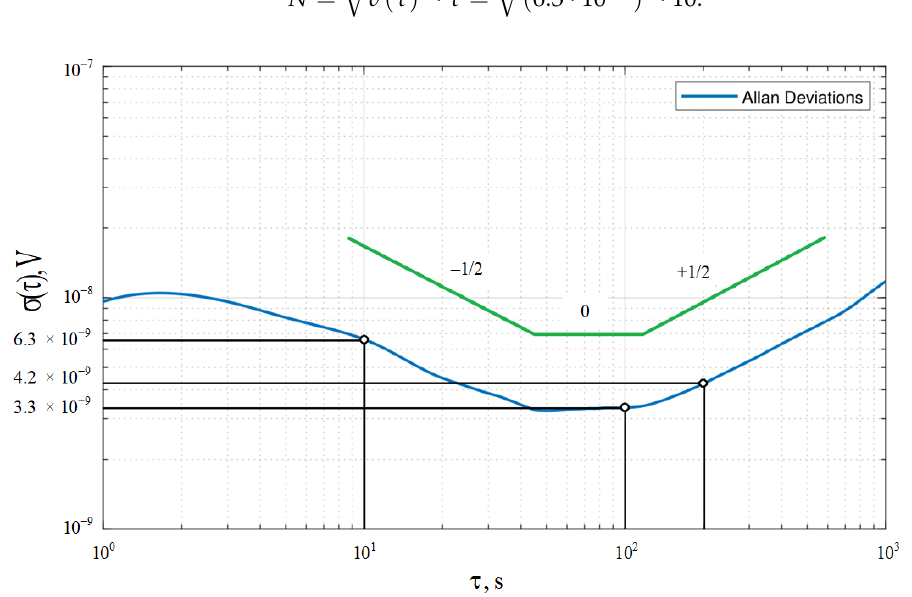
Figure 10. Allan variance of the lock-in amplifier.